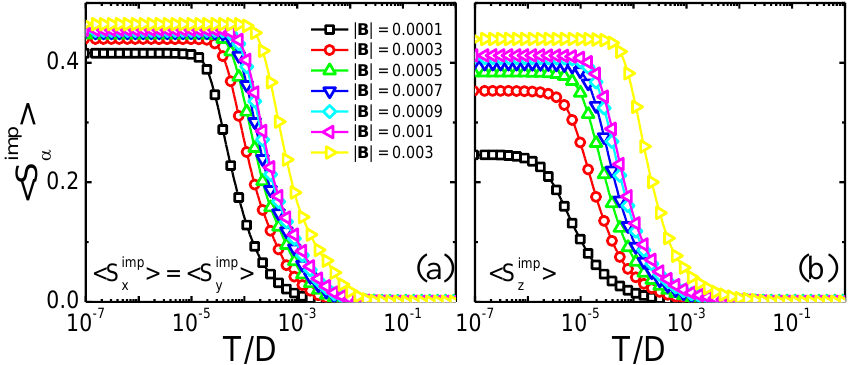
Figure 6. Impurity polarization (cid:104) S imp α = x , y , z (cid:105) as a function of temperature for different applied magnetic fields. ( a ) Magnetic field along x - and y -direction. ( b ) Same curves as in panel ( a ), but for magnetic field along the z -direction, with λ SO = 0.1 for both